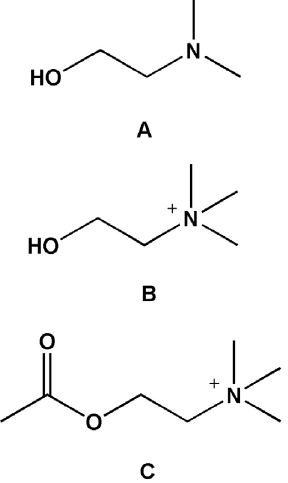
FIGURE 1 - Chemical structure of DMAE (A), choline (B), and acetylcholine